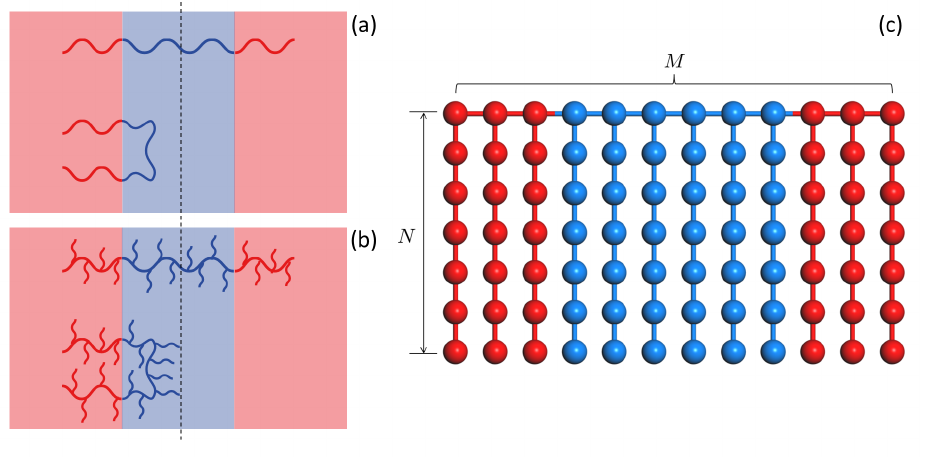
Figure 1. Illustration of ( a ) bridge and loop conformation for ABA linear triblock copolymer (L-TBC), ( b ) those of ABA comb triblock copolymer (C-TBC) in the phase-separated domains, and ( c ) the chain architecture of C-TBC investigated in this study. In ( a,b ), the red-colored regions and the blue-colored region are the A- and the B-domain, respectively, and the dashed line in the B-domain represents the